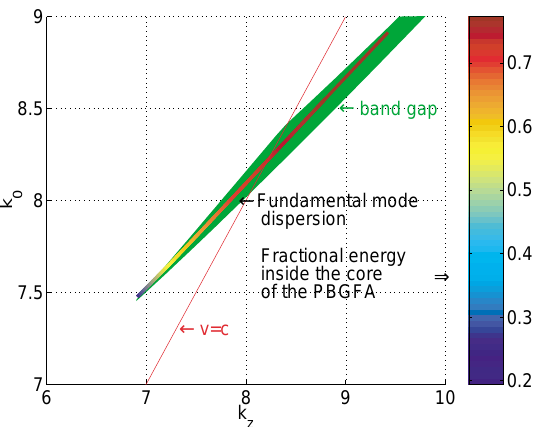
FIG. 5. (Color) The dispersion of the defect mode. The green band is the band gap responsible for localization. The dispersion curve is color coded by the energy fraction inside the core of the PBG